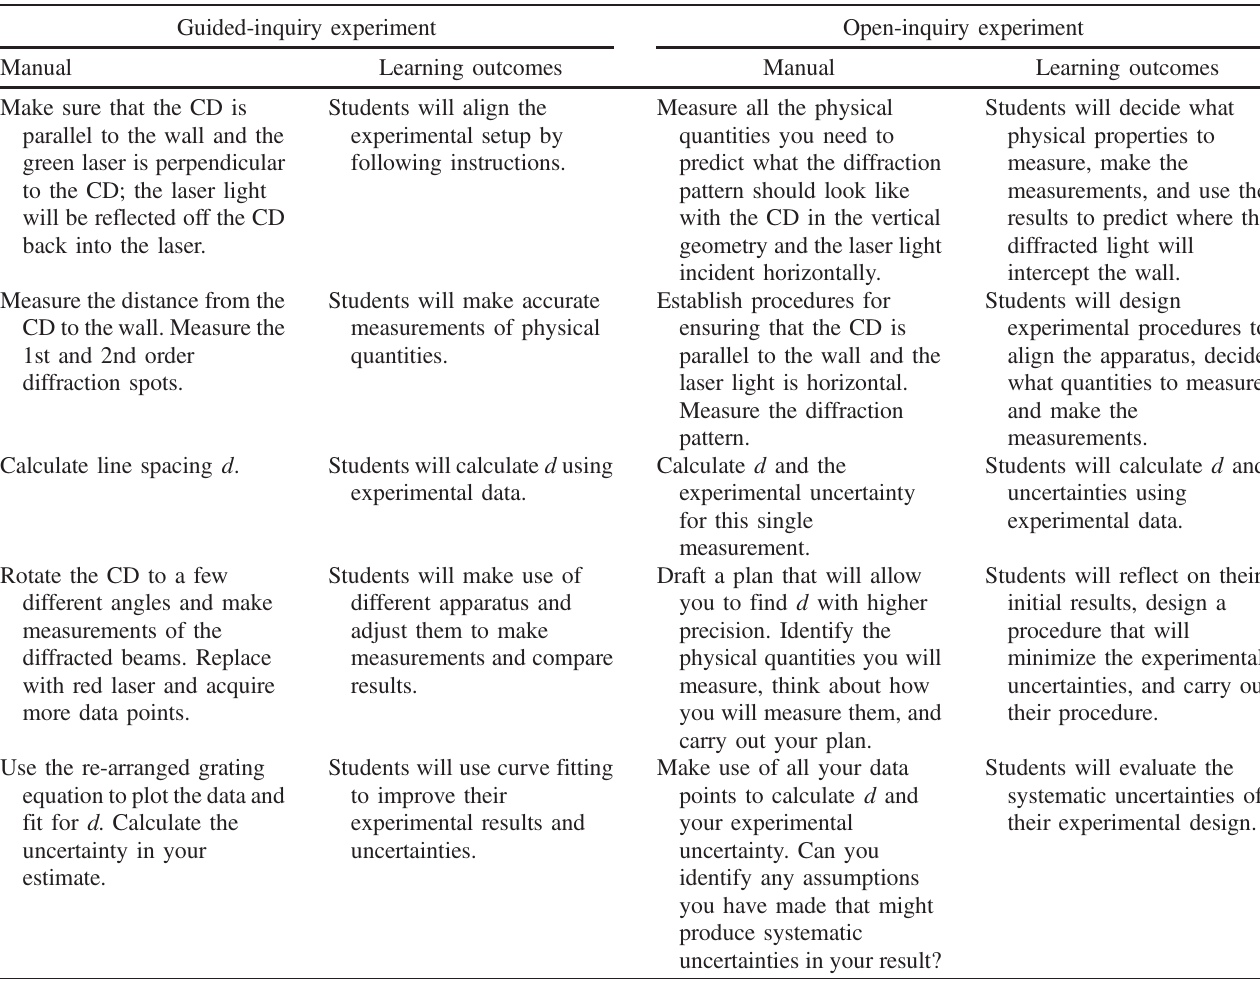
TABLE I. Comparison of guided- and open-inquiry manuals and learning outcomes for the CD diffraction experiment. Students are provided with recipelike procedures in the guided-inquiry manual while they are prompted to design some of the experimental activities themselves in the open-inquiry